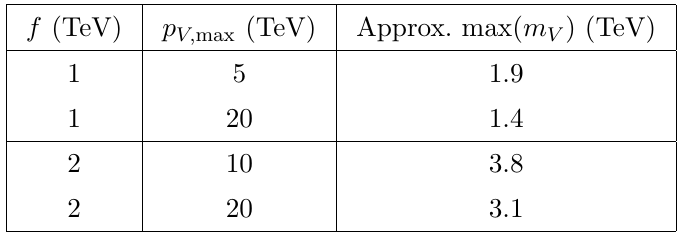
Table 1 . Bounds on the vector dark matter mass m V for given illustrative cuto(cid:11) values f and typical maximum centre-of-mass vector momentum p V; max